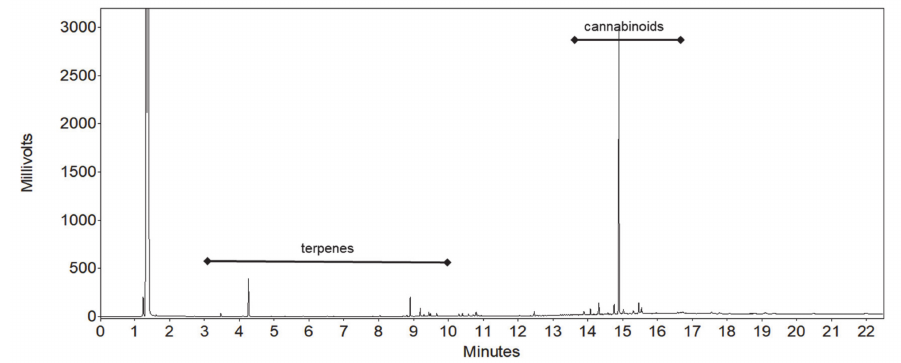
Figure 3. Chromatogram of hemp sample extract (full